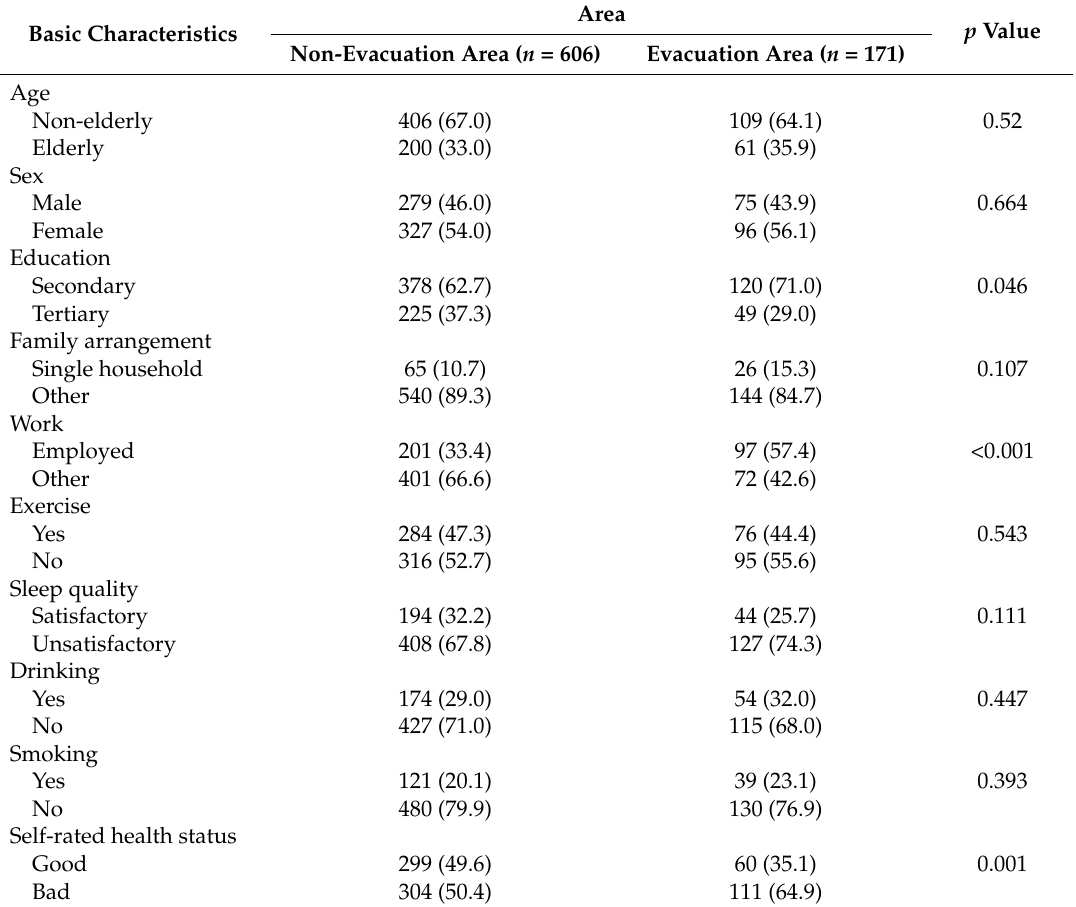
Table 2. Characteristics of research